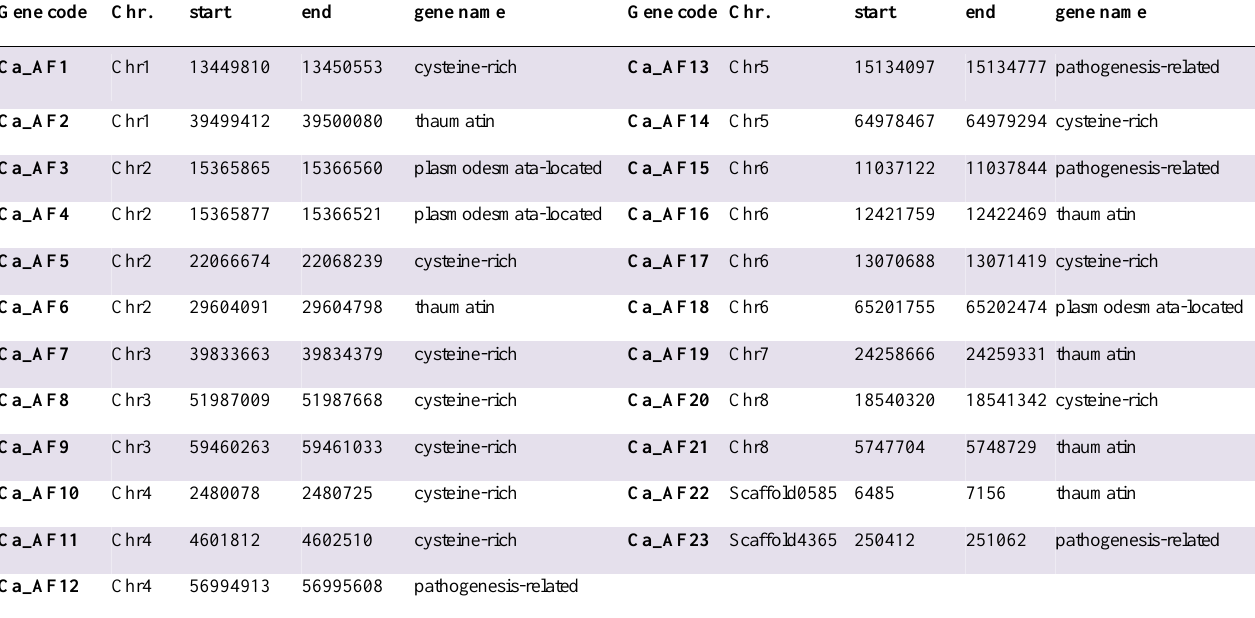
Table 1: The chromosomal location and gene definition for identified anti-fungal genes in chickpea genome. Gene